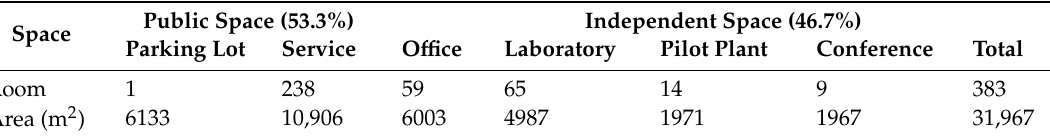
Figure 3. The electricity consumption of CTIC. Table 2. Basic information of the selected 31 rooms. OrderRoom